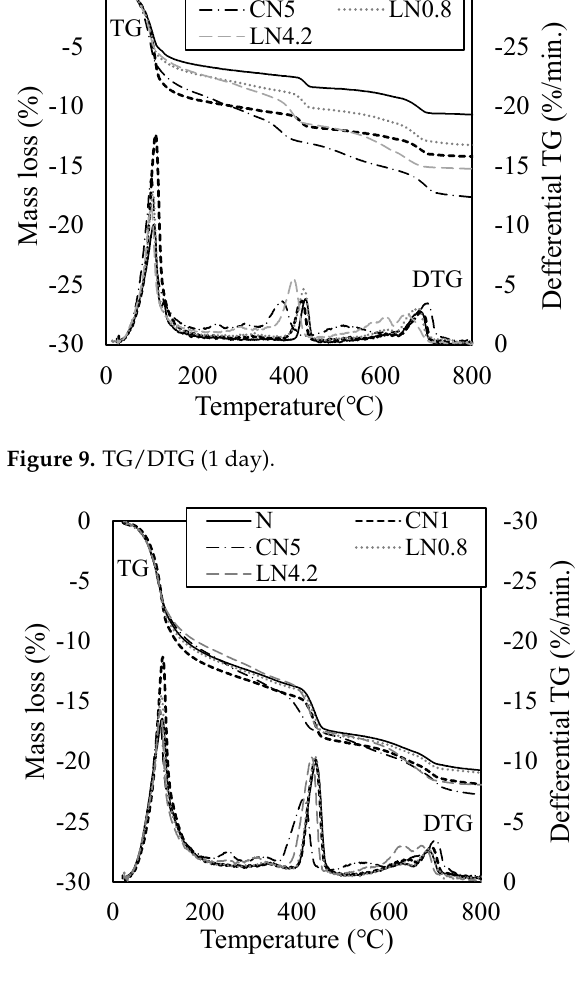
Figure 10. TG/DTG (7 days).